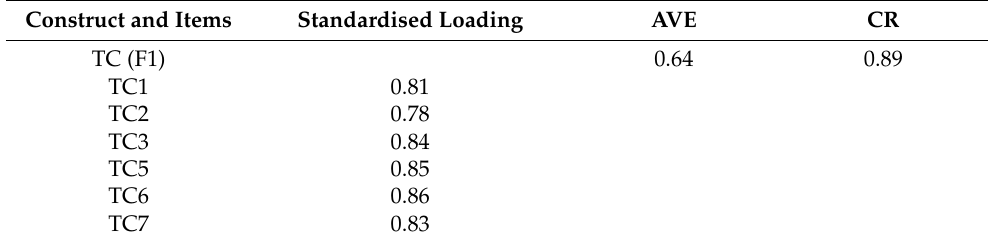
Table 7. Standardised loadings, AVE, and CR coefficients of the first-order four-factor